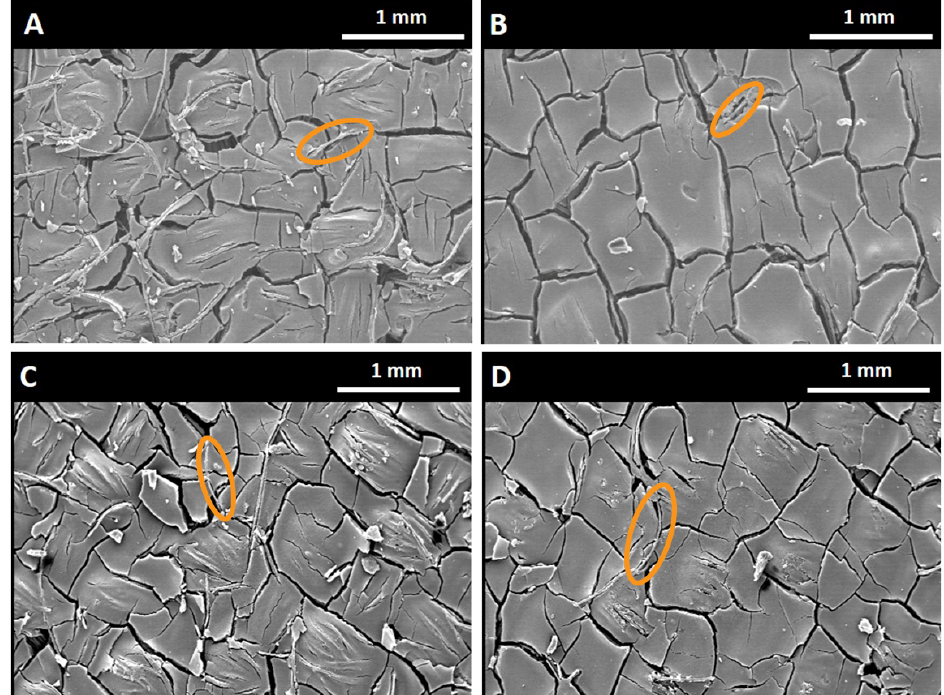
Figure 2. SEM images of the CMC-containing MPLs: ( A ) CMC-0.25 DL, ( B ) CMC-0.5 DL, ( C ) CMC-1 DL, ( D ) CMC-2 DL. Orange ellipses highlight examples of partially exposed fibers.